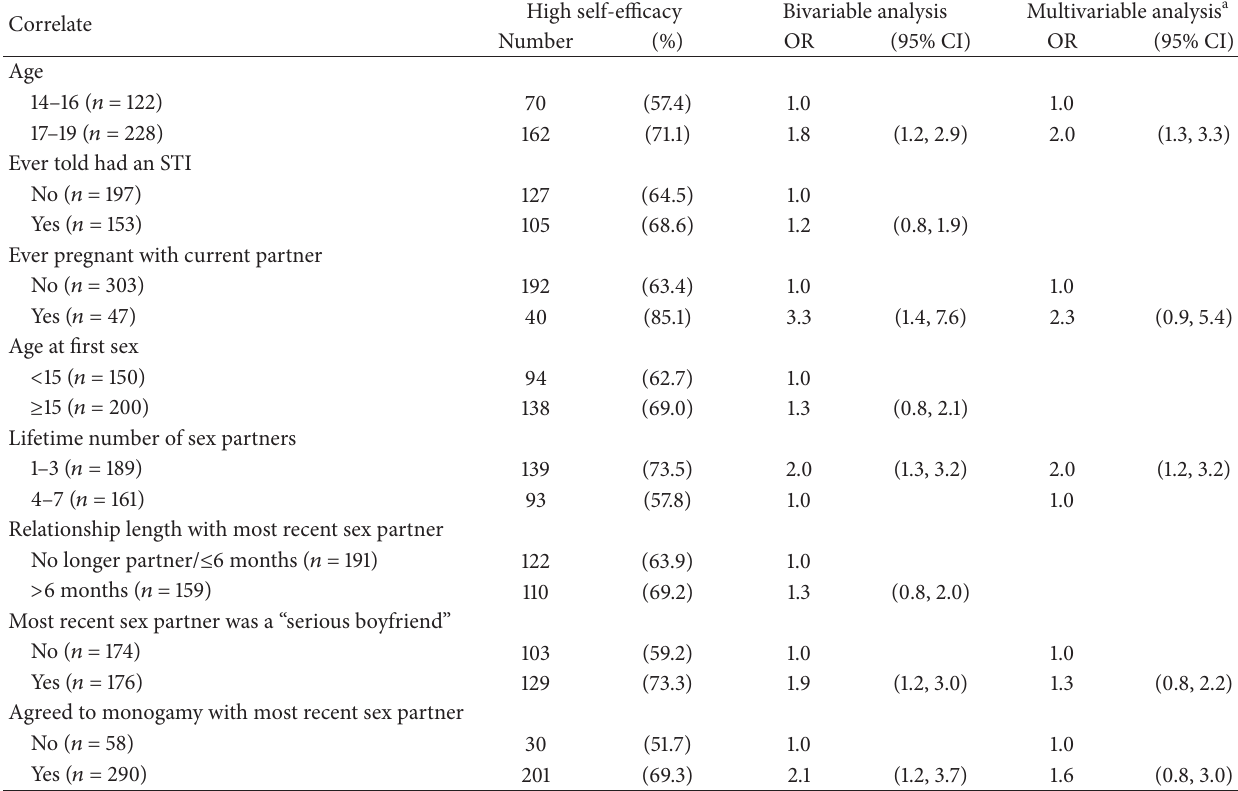
Table 3: Baseline correlates of high self-efficacy for partner notification ( 𝑁 =